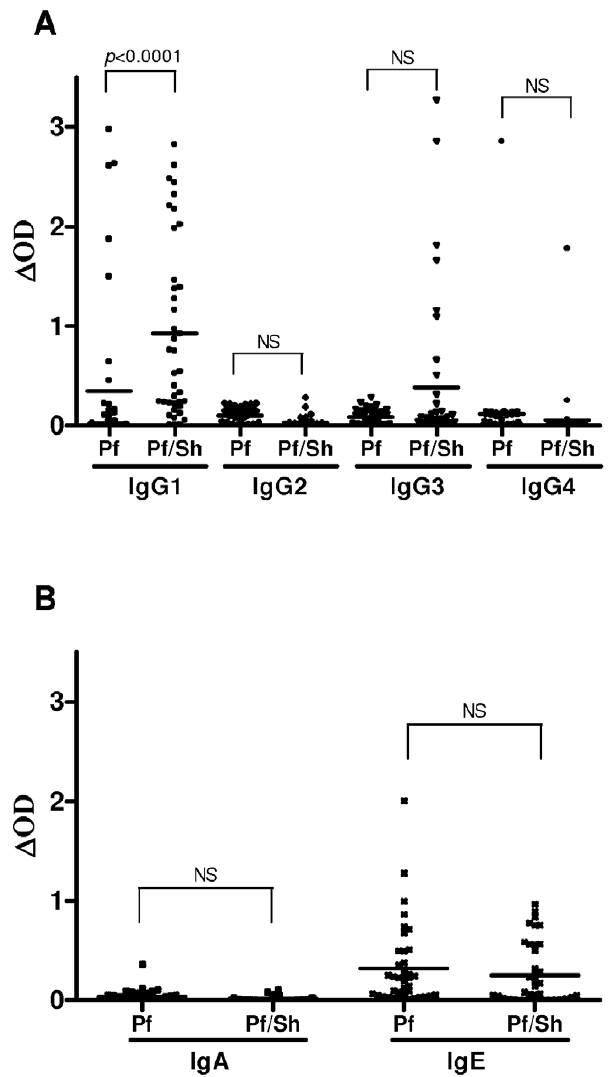
Figure 1. Specific Ab responses to PfMSP1- 19 in children infected by P. falciparum ( Pf - n=40) and coinfected with S. haematobium ( Pf-Sh - n=39) as determined by ELISA. Results represent individual values of D OD and bars are the arithmetic mean for each group. Statistical significance between each group is indicated. (A) isotypes IgG1, IgG2, IgG3 and IgG4, (B) isotypes IgA and